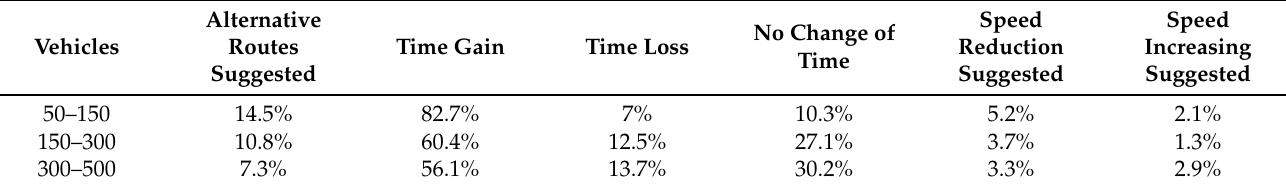
Table 5. Experimental results (% cases). Simulation on traffic